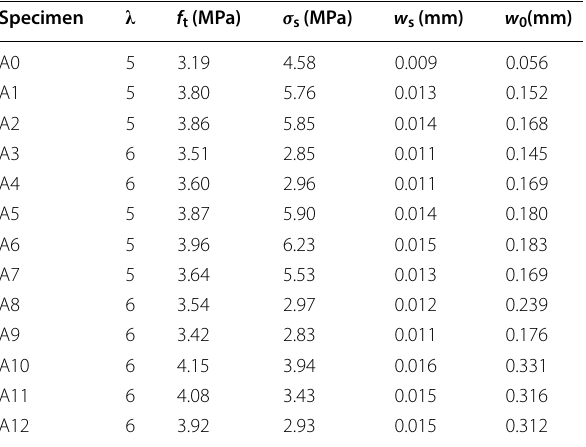
Table 5 Parameters of bilinear softening curve of hybrid-fiber